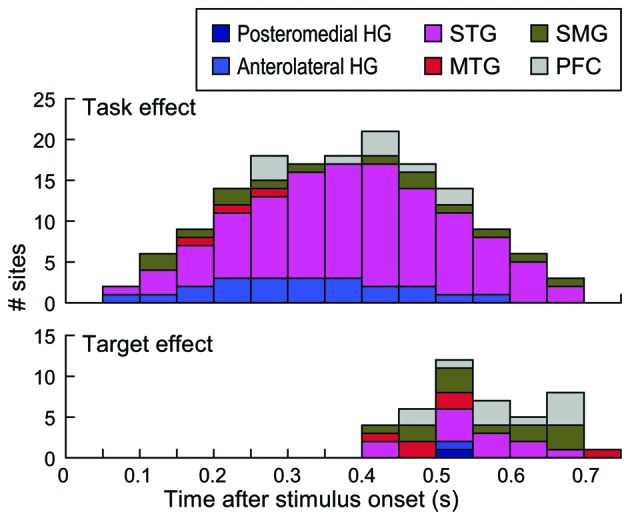
Timing of task and target effects. Stacked bars denote the number of sites within each of the six regions of interest across all subjects that exhibited a significant task or target effect (top and bottom graph, respectively) within time intervals from 50–100 to 700–750 ms after stimulus onset. Intervals up to 550 ms included data from all nine subjects, because this window preceded behavioral responses in all subjects. Time windows beyond 550 ms reflect data progressively fewer subjects based on their RTs (see “Materials and Methods” Section).